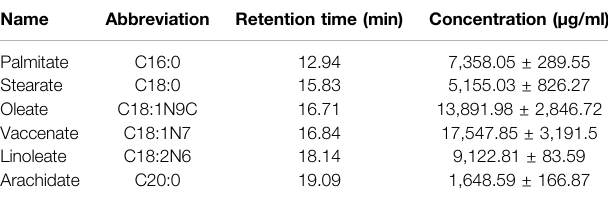
TABLE 1 | Top 6 fatty acids in BO (mean ± SD, n (cid:2)